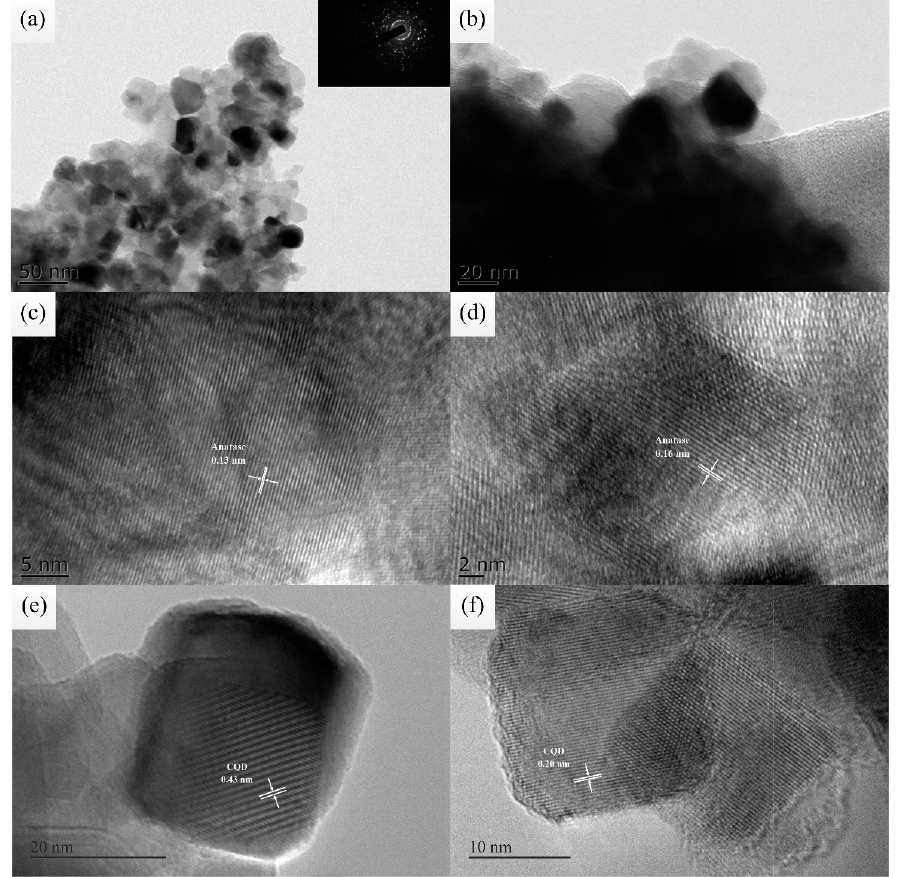
Figure 3. TEM images of the TiO 2 /CNT/CQD mesoporous composite: ( a , b ) are TEM images of the TiO 2 /CNT/CQD mesoporous composite, ( c , d ) are HRTEM images of the anatase phase, ( e , f ) HRTEM is images of the CQD phase.